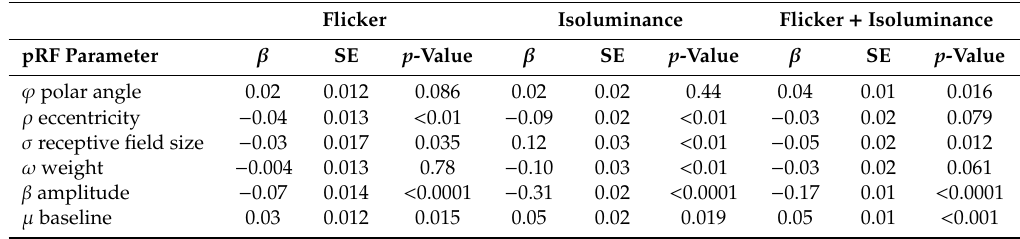
Table 2. Regression results. We regressed each of the spatiotemporal pRF model estimates against the intrinsic functional clusters derived from data measured while subjects viewed a full-field flicker and isoluminant stimuli. Beta coe ffi cients are